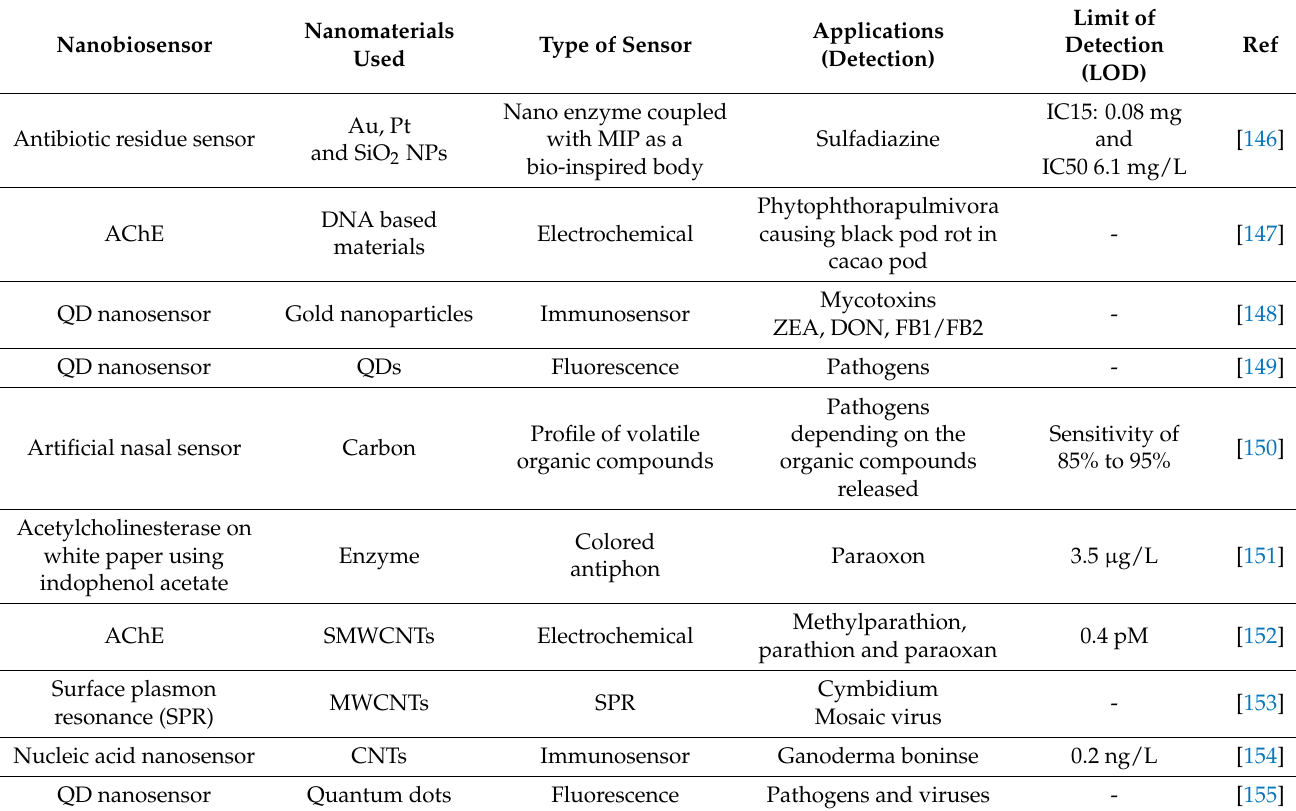
Table 7. Different types of nanobiosensors in biomedical